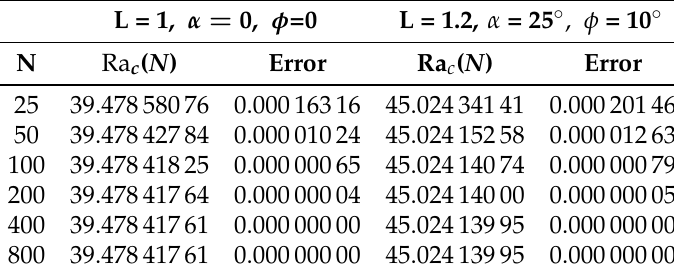
Table 1. Accuracy tests for the given cases with n =